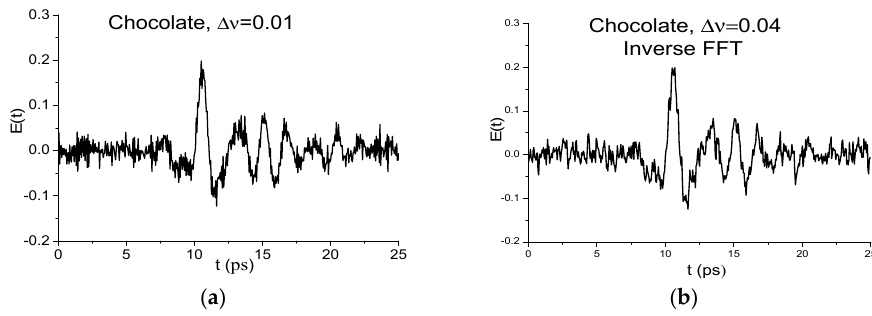
Figure 5. The main pulse of the measured THz signal Chocolate ( a ) and recovered with inverse Fourier transform signal Chocololate_0.04 ( b ) in the time interval t = [0, 25] ps.